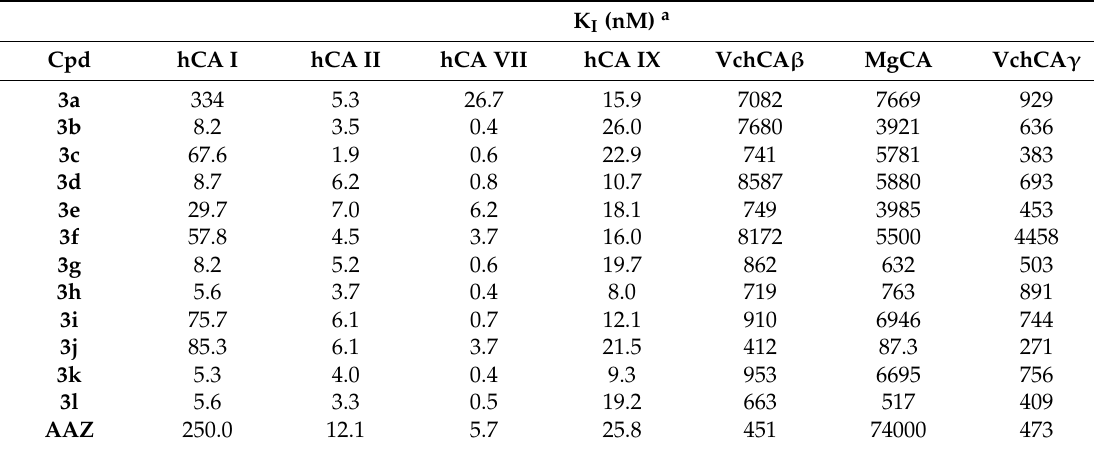
Table 1. Inhibition data of human carbonic anhydrase (CA) isoforms hCA I, II, VII, IX, and pathogenic bacteria and fungi β - and γ -CAs with compounds 3a – 3l in comparison with the standard sulfonamide inhibitor AAZ by a stopped flow carbon dioxide (CO 2 ) hydrase assay